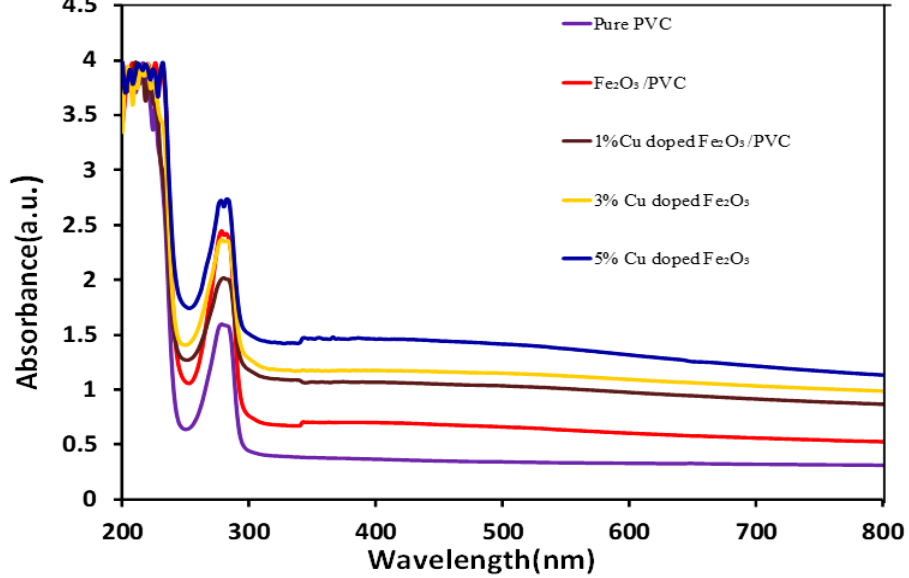
Figure 5. A comparison of absorption spectra of PVC and its composites.